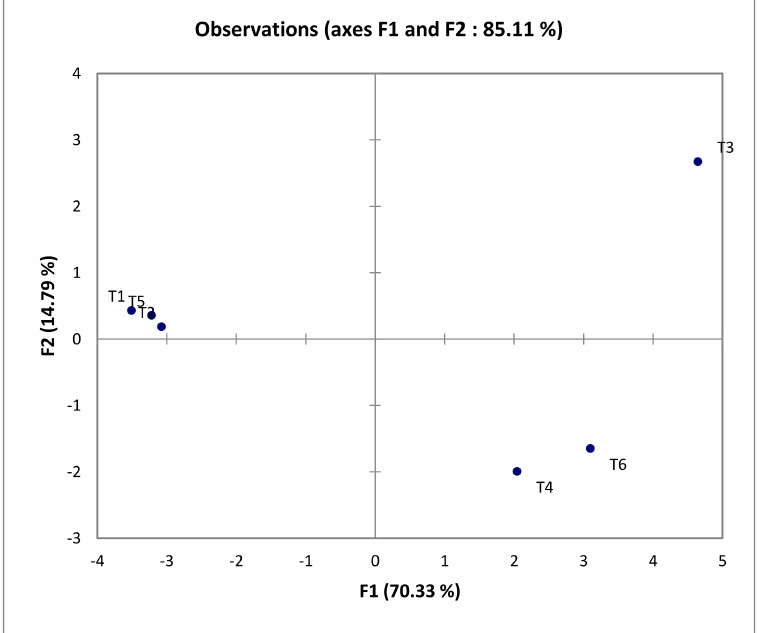
Figure 12. Principal component analysis for water sampled during the tenth campaign: projection of individuals on the plane